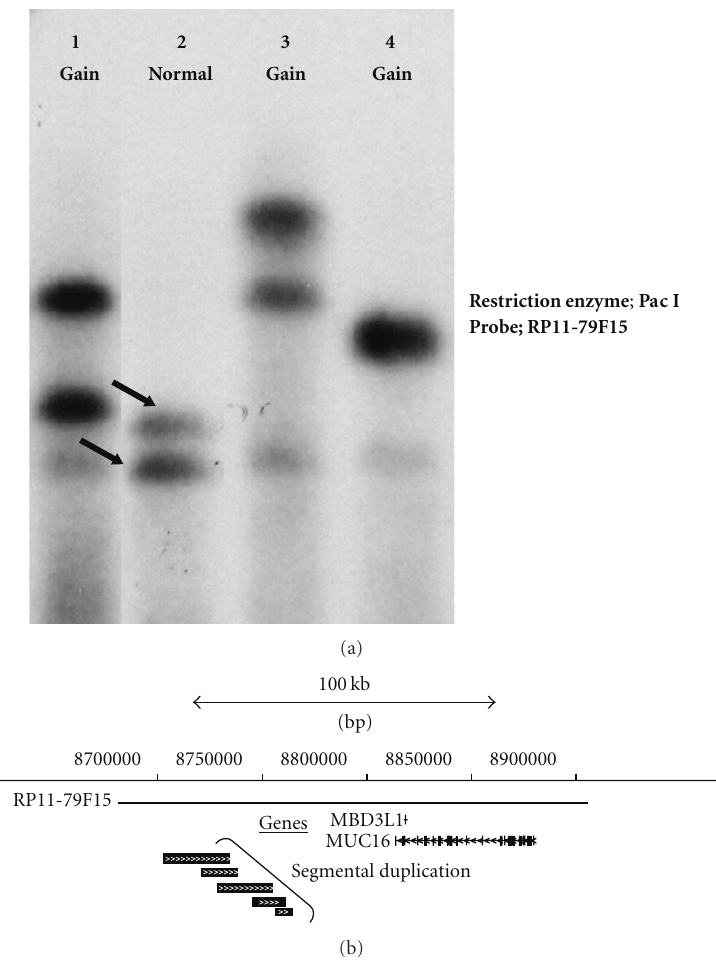
Figure 1: (a) Typical patterns of CNVs detected on the BAC clone (RP11-79F15) from Southern blot analyses after PFGE. (b) The Genome Map from the UCSC genome Browser. (a) The figure illustrated the pattern from three individuals showing gain on the array and one showingnormalon the array. When the fragmentlength of the “Gain” (lanes;1, 3, 4) was compared with “Normal” (lane2), the segment sizes of the three (lanes; 1, 3, 4) individuals were larger than those (shown by arrows) of “Normal.” As shown in (b), five segmental duplications existed at the 5 (cid:4) -region of the BAC clone. That is, as these three (lanes; 1, 3, 4) contained a larger number of core segments (shown by blocks in (b)), the signals on the BAC spot were stronger than normal. So, those three were identified as